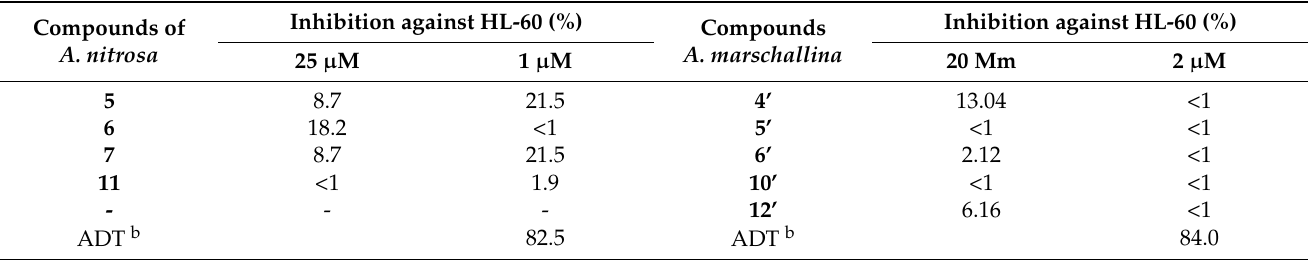
Table 4. Cytotoxic activities of isolated compounds from A. nitrosa and A. marschalliana against the HL-60 cell